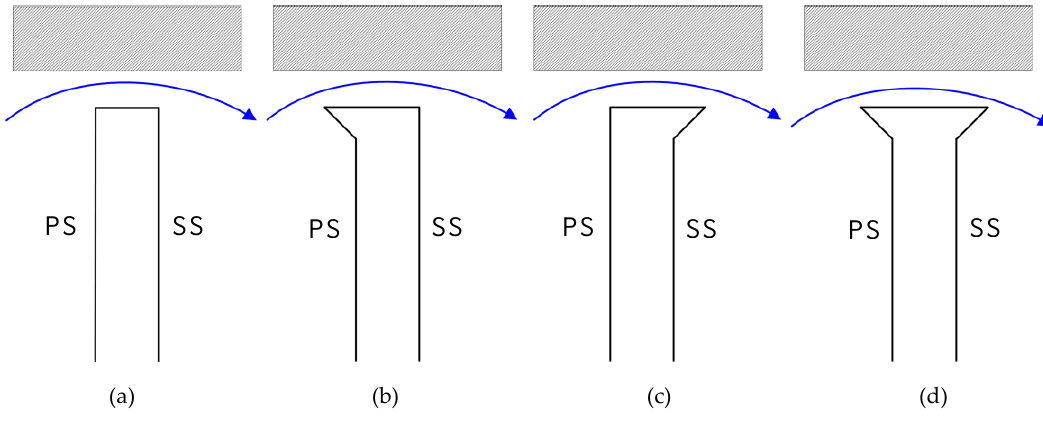
Figure 3. Proposed T-shape tips. ( a ) M0; ( b ) MPT; ( c ) MST; ( d ) MT.